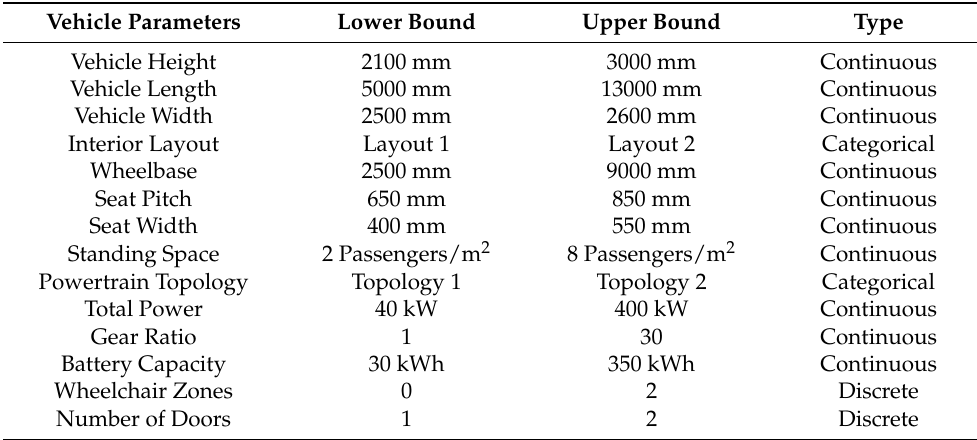
Figure 2. Value Functions showing the correlation between the objective value and technical specifications. Value function of ( a ) waiting time, ( b ) seating ratio, ( c ) seat pitch, ( d ) standing space, ( e ) vehicle top speed, ( f ) wheelchair zones. Table 2. Optimization parameters of the vehicle